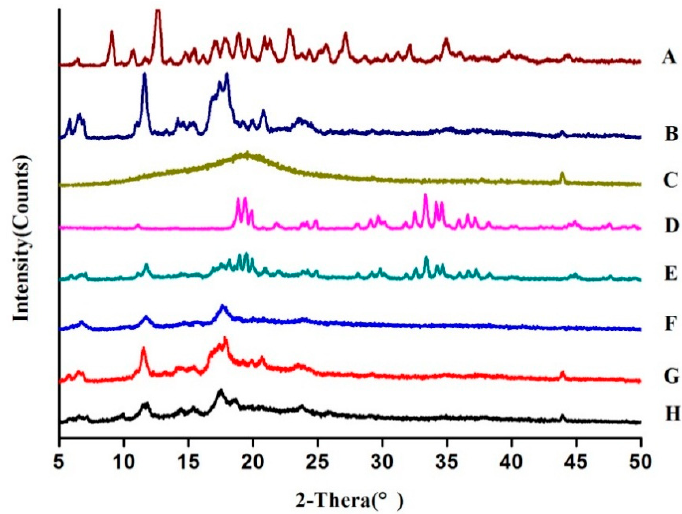
Figure 4. X-ray diffraction (XRD) patterns of different materials. A: β -CD; B: GEO/ β -CD composite; C: Chitosan; D: STPP; E: Physical mixture (with STPP); F: GEO/ β -CD/CTS particles; G: Physical mixture (without STPP); H: GEO/ β -CD/CTS microsphere.